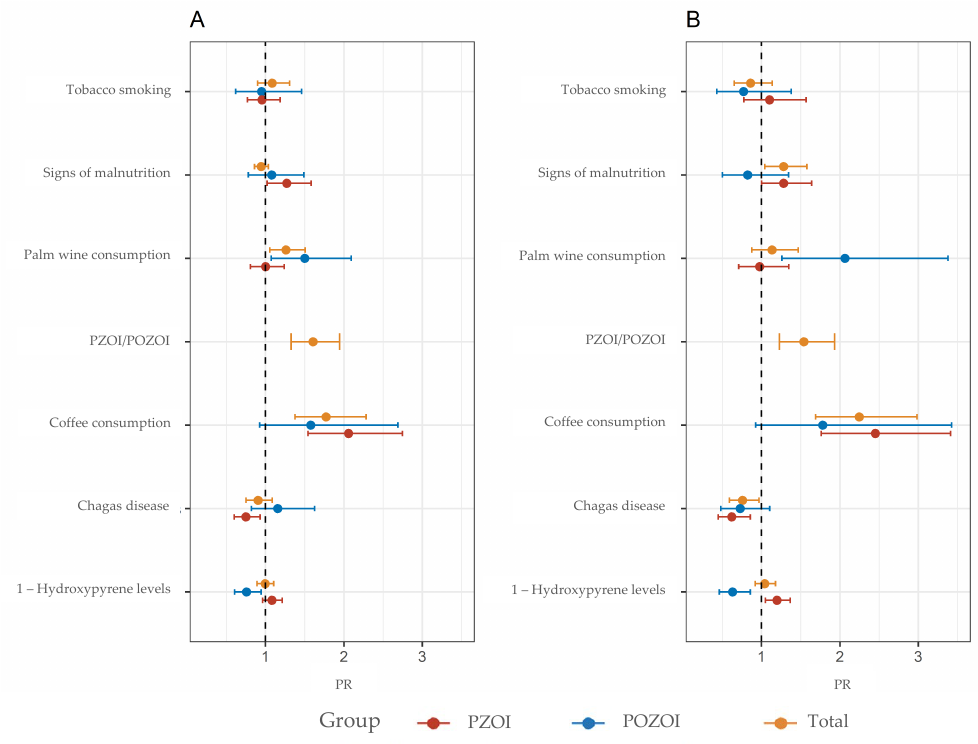
exploitation areas, and urine levels of 1-OHP. These effects were expressed as the PR and Figure 2. PR for MN frequency based on a Poisson regression model for PZOI and POZOI groups. the 95% confidence interval. ( A ) Unadjusted and ( B ) adjusted for covariates.